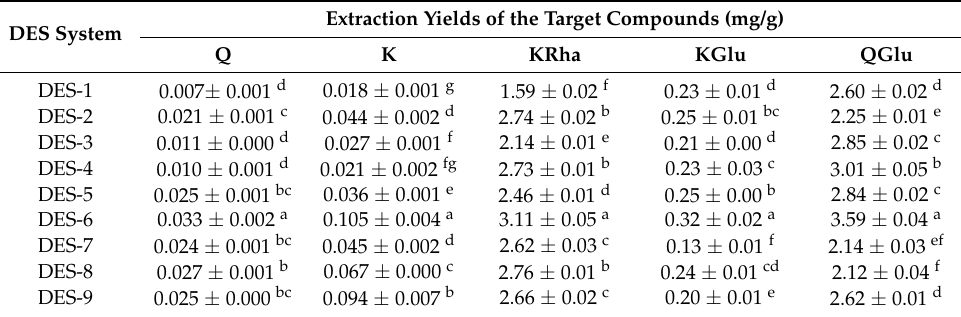
Table 4. Influence of the DES composition on the extraction